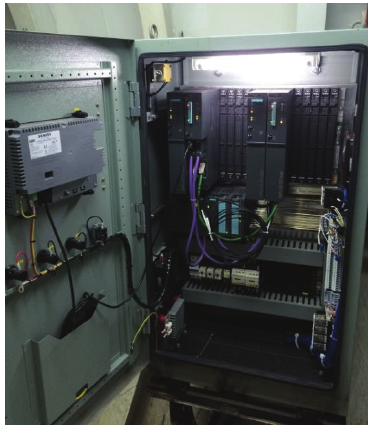
Figure 26: Underwater vehicle speed control unit.